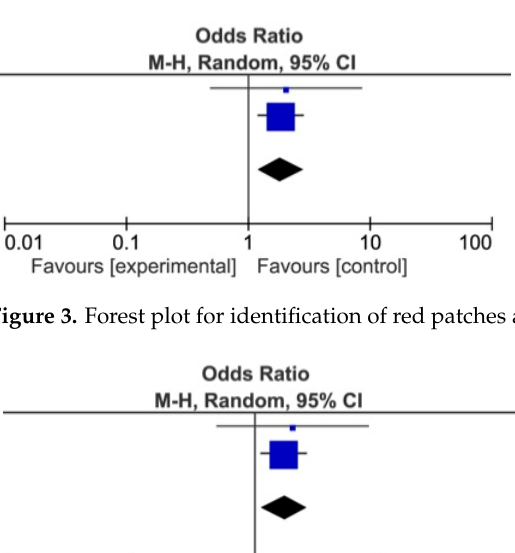
Figure 2. Forest plot for identification of alcohol as oral cancer risk factor among DDs and MDs.